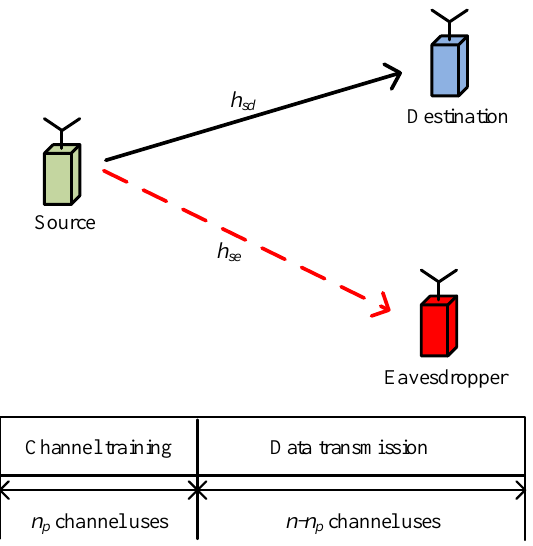
Figure 1. System model and packet structure for short-packet